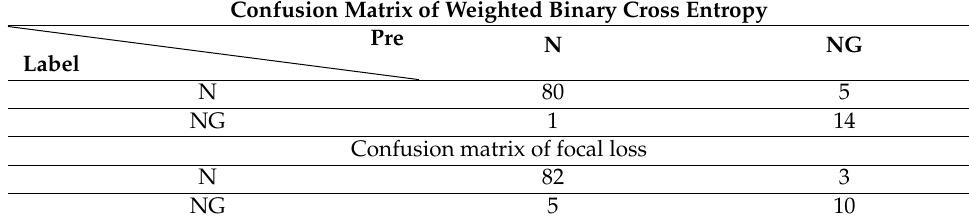
Table 9. Confusion matrix of XGBoost.